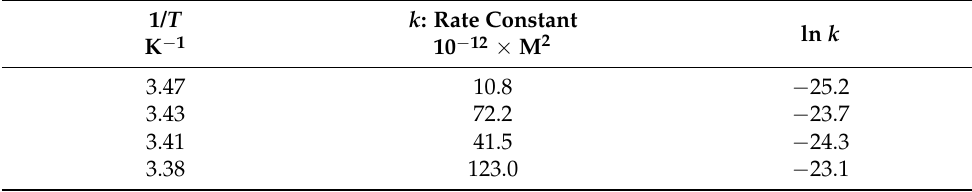
KOH buffer at pH 7.4. The volume of the sample solution was 0.4 mL. The ammonium production reaction time was 1 min. Each ammonium production rate (v) reported is the average production rate values obtained from three activity tests. Table A2. Values used to generate the Arrhenius